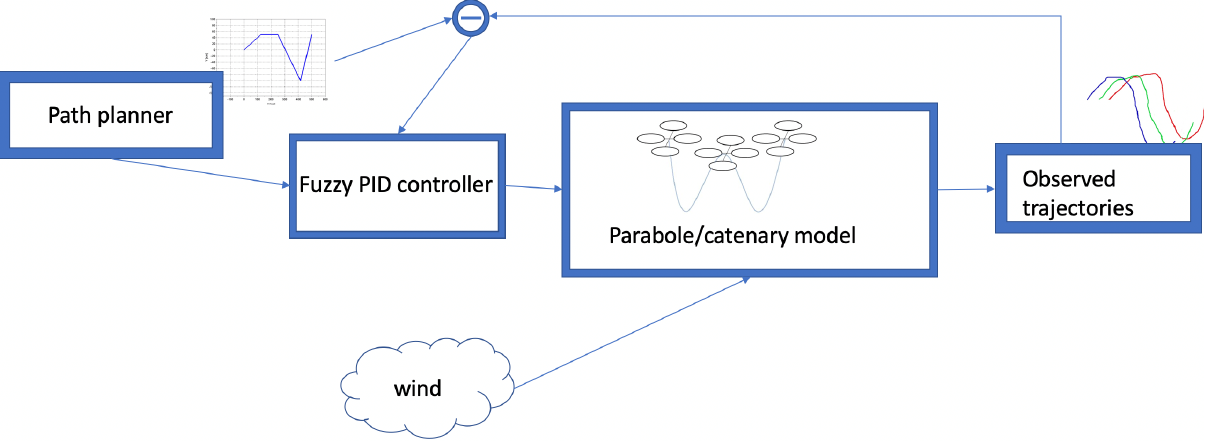
Figure 1. Overall block